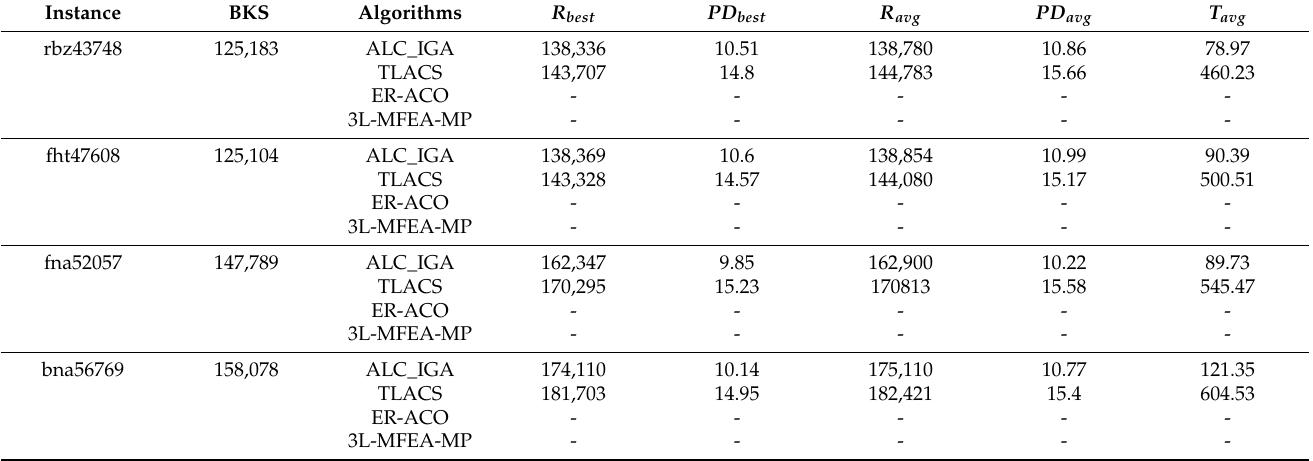
Table 7. Comparison of ALC_IGA and three relevant algorithms in parallel in large-scale